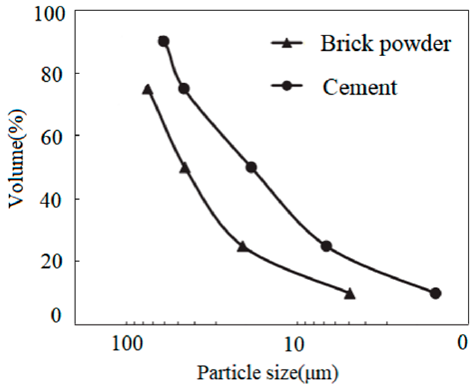
Figure 3. The size distribution of cement and RBP.